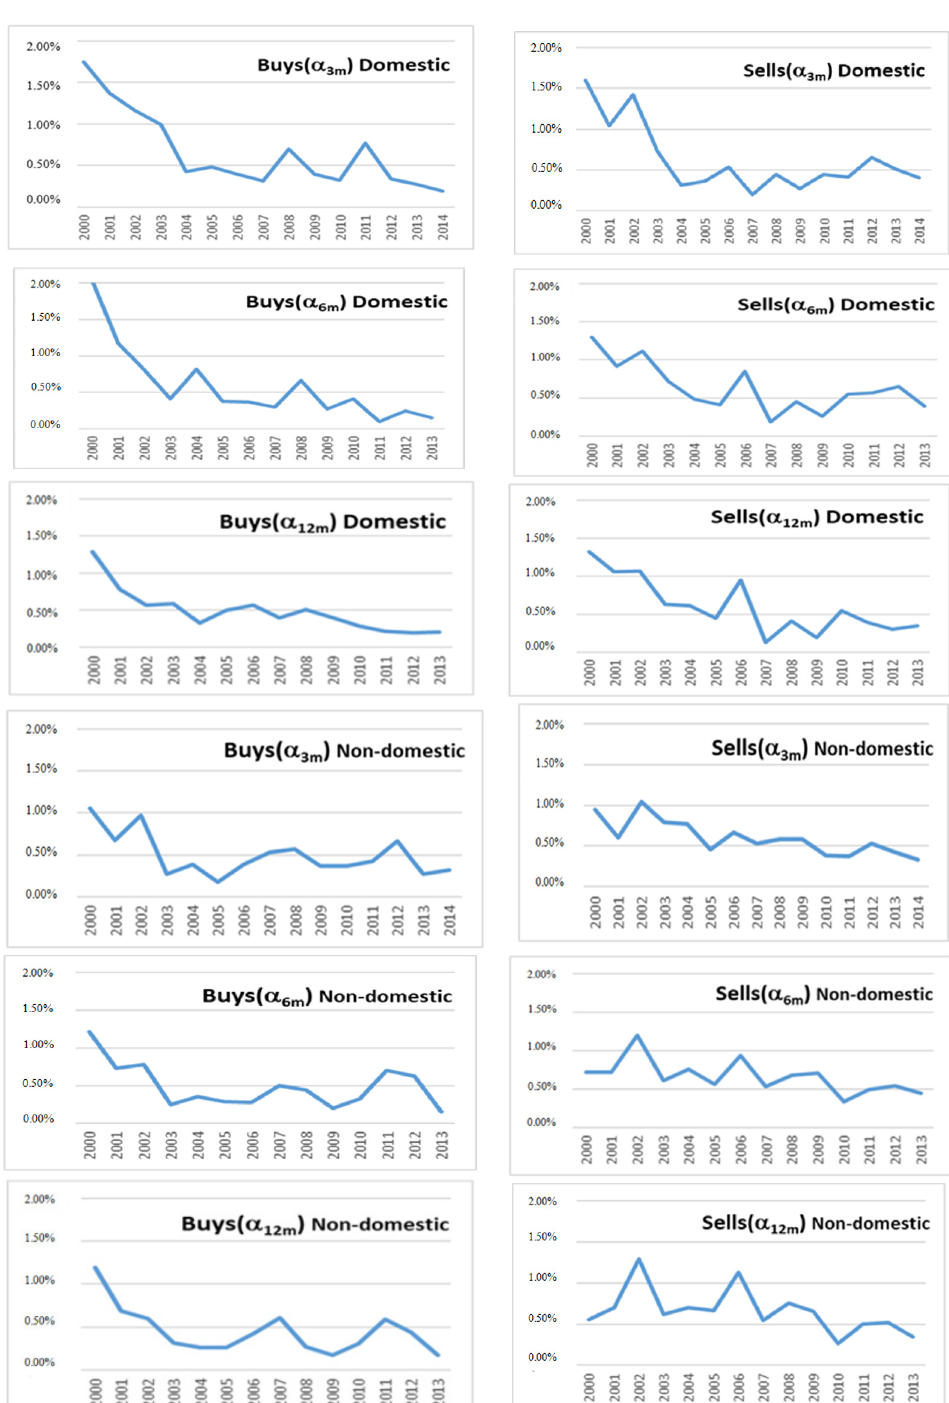
Figure A1. The evolution of important errors. These graphs show the evolution of the percentage of important trading errors in buys and sells for Euro domestic equity mutual funds (Domestic) and Euro non-domestic equity mutual funds (Non-domestic) from January 2000 to March 2014. The results are divided into buys and sells after considering different time horizons to compute the subsequent effect of these errors: 3-month alpha, 6-month alpha, and 12-month alpha.